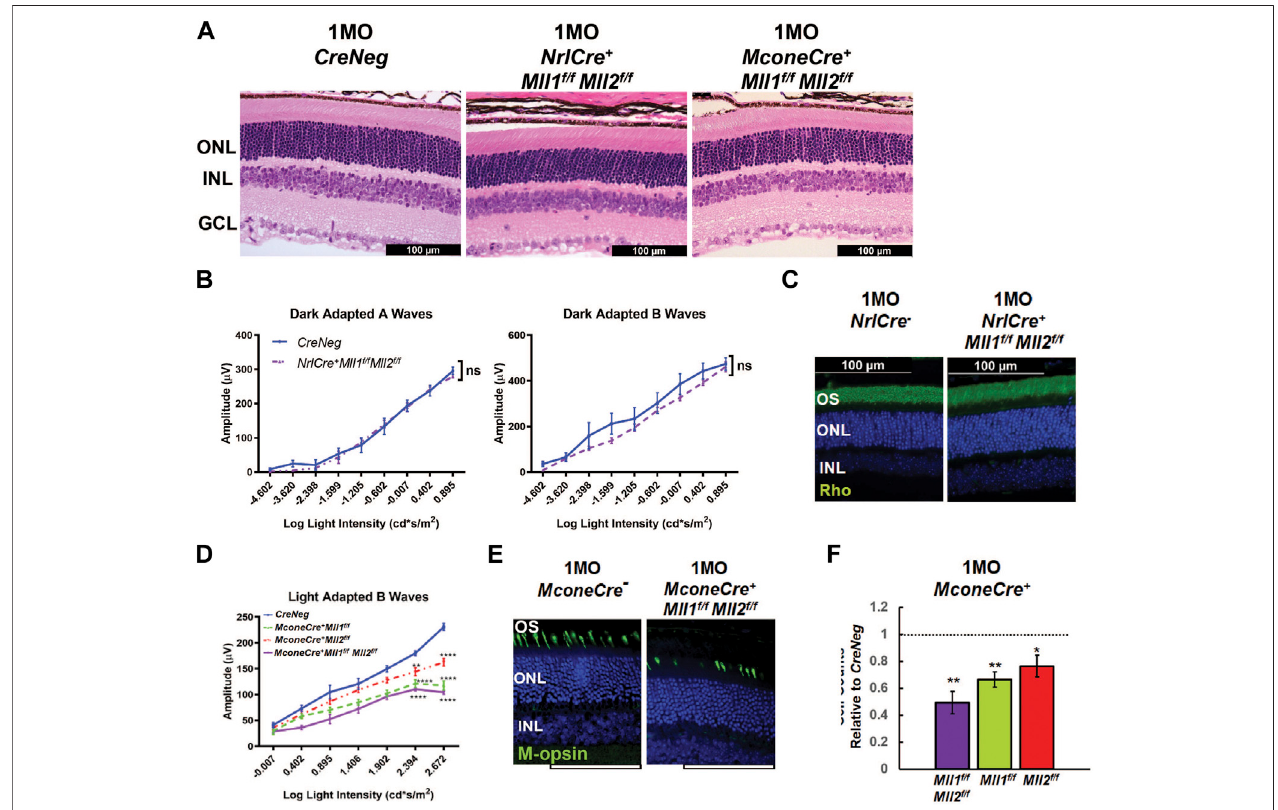
FIGURE 7 | Functional and morphological assessments of 1MO NrlCre + Mll1 f/f Mll2 f/f and MconeCre + Mll1 f/f Mll2 f/f . (A) H&E cross-section staining of 1MO Cre - ( CreNeg, leftpanel), NrlCre + Mll1 f/f Mll2 f/f (centerpanel) MconeCre + Mll1 f/f Mll2 f/f (rightpanel)retinae.Scalebar=100 µmforallimagepanels. (B) DarkadaptedA-wave(left) andDarkadaptedB-wave(right)ERGanalysisof1MO NrlCre + Mll1 f/f Mll2 f/f and Cre - ( CreNeg )mice.Meanamplitudes(µV)areplottedagainststimuluslightintensity.Error bars represent SEM ( n ≥ 4). (C) Rho immunostaining in 1MO NrlCre - and NrlCre + Mll1 f/f Mll2 f/f retinae. (D) Light adapted B-wave ERG analysis of 1MO MconeCre + Mll1 f/f Mll2 f/f , MconeCre + Mll1 f/f , MconeCre + Mll2 f/f , and Cre - ( CreNeg ) mice. Mean amplitudes (µV) are plotted against stimulus light intensity. Error bars represent SEM ( n ≥ 4). (E) M-opsinimmunohistochemical staining in 1MO MconeCre - and MconeCre + Mll1 f/f Mll2 f/f dorsal retinae. (F) Cell counts for M cone photoreceptors in 1MO MconeCre + Mll1 f/f Mll2 f/f MconeCre + Mll1 f/f , and MconeCre + Mll2 f/f retinae, normalized to counts from MconeCre - ( CreNeg ) littermates. Error bars represent mean (SD) ( n = 3). All statistics is done by two-way ANOVA and Tukey ’ s multiple comparisons. Asterisks (*, **, ***) denote p ≤ 0.05, p ≤ 0.01, p ≤ 0.001 respectively, ns means not signi fi cant.